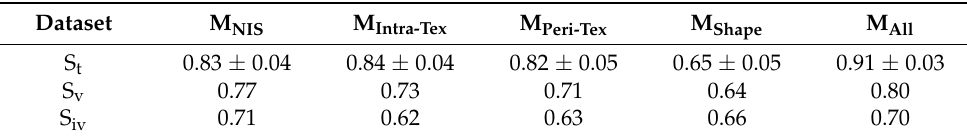
Table 1. Classification results (AUCs) of M NIS and other classifiers trained on S t and validated on S v and S iv